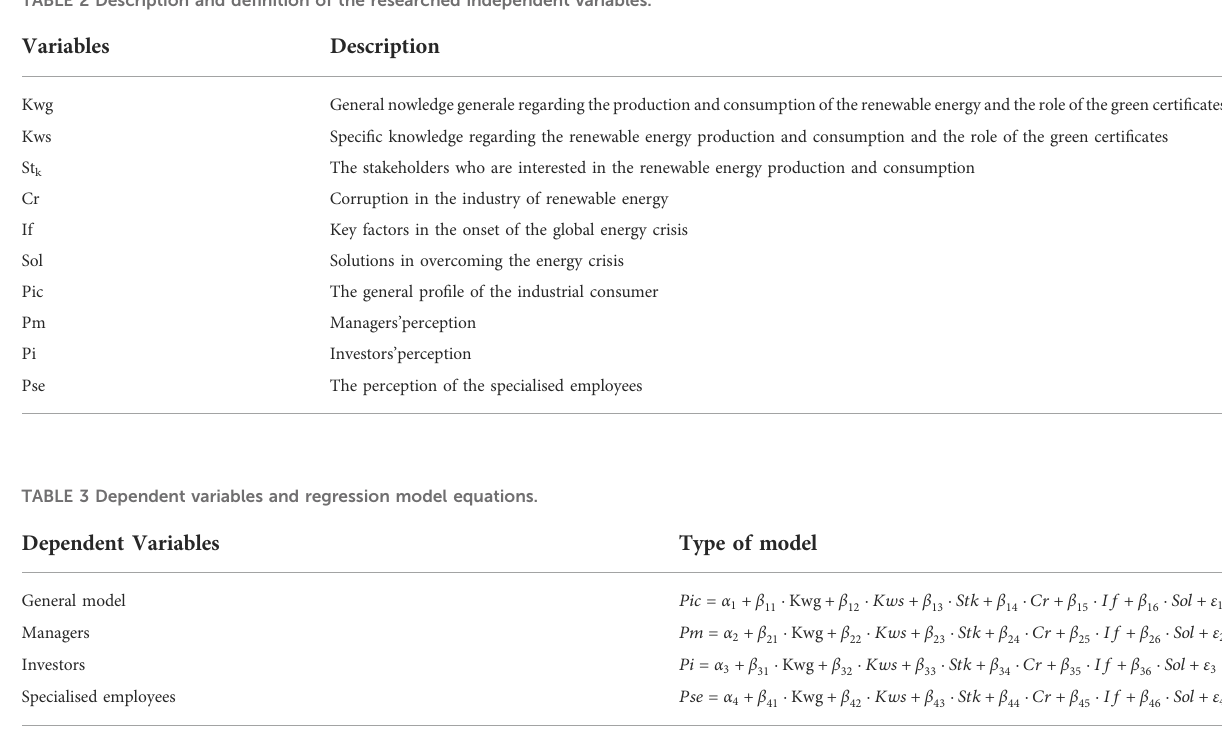
TABLE 2 Description and de fi nition of the researched independent variables.